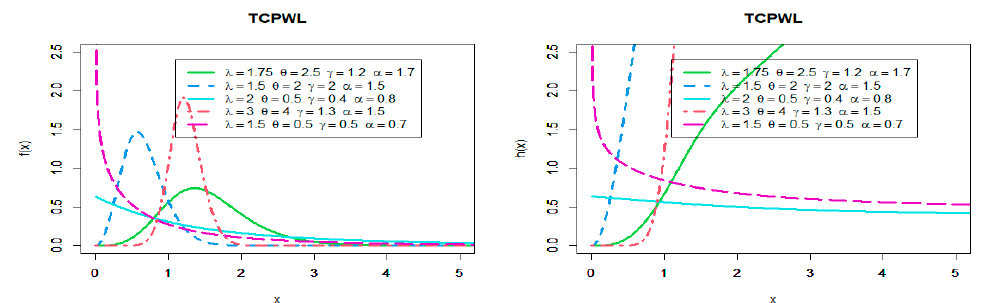
Figure 1. Plots of PDF and the hazard function of TCPWL distribution.